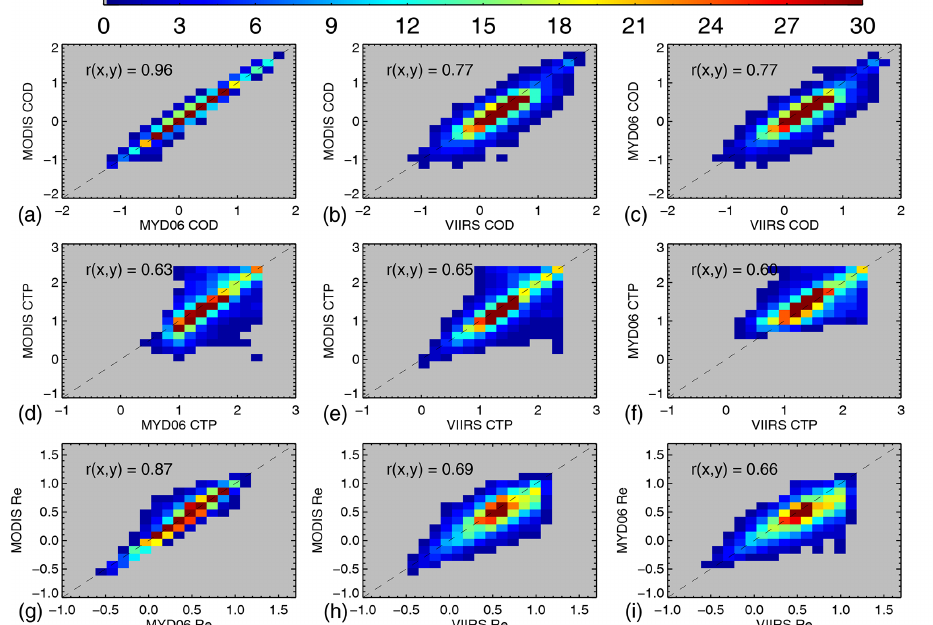
Figure 8. Similar to Fig. 7, except showing comparisons of the standard deviation of cloud properties over the sounder FOV, which are calculated using the finer-resolution imager observations collocated with the same sounder FOV. All the results are presented on a log 10 scale. Linear correlation coefficients between the variables on the x and y axes are given in each plot.